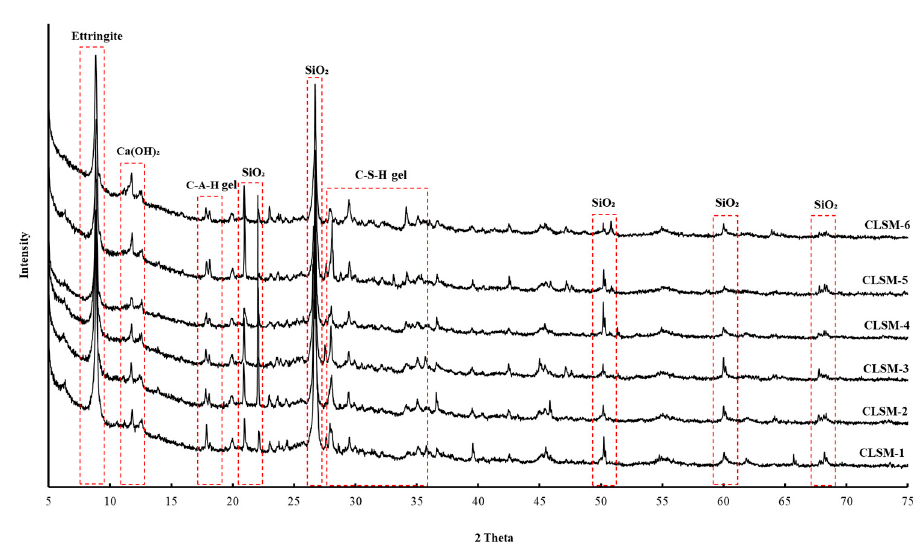
Figure 9. 28-d XRD results for different W/B values.